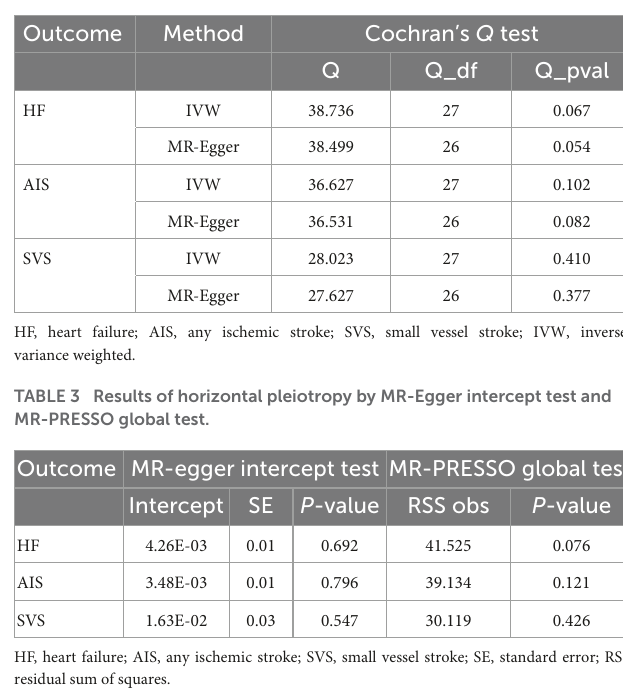
Frontiers in Cardiovascular